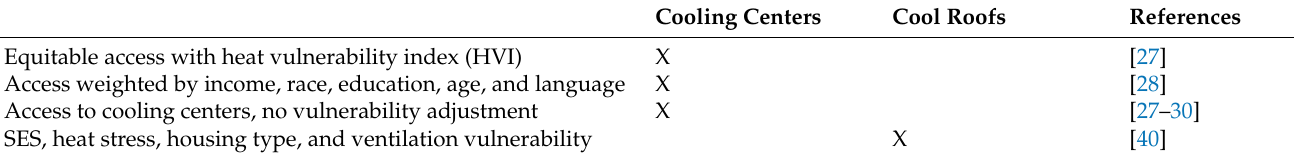
Table 4. Population accessibility and vulnerability.